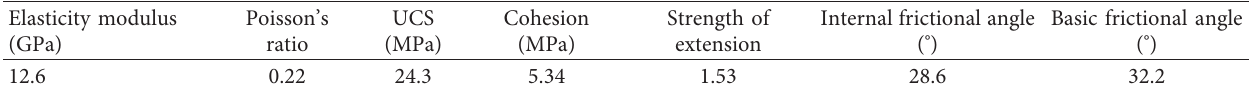
Figure 2: Concrete joints with uniform topography: (a) 3D printed joint surface derived from the tenth standard JRC profile [3]. (b) Assembled moulds of PLA joint surface and outer metal frame. (c) Concrete joint specimens and shear boxes. Table 2: Mechanical properties of concrete